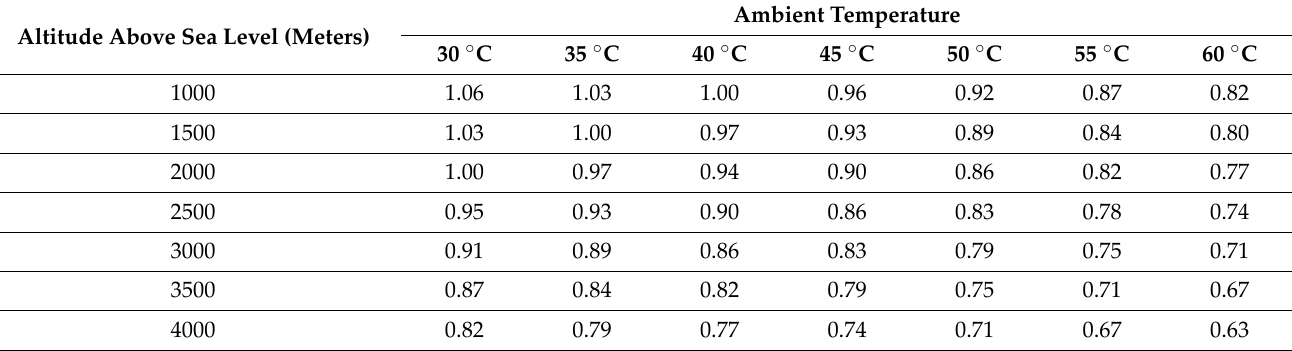
Figure 3. SoP estimation and diagnosis of the motor drive in the EV based on the authors’ previous contributions in [21,23]. Table 1. Derating factor versus different levels of ambient temperature and altitude (taken from SIEMENS © motor application